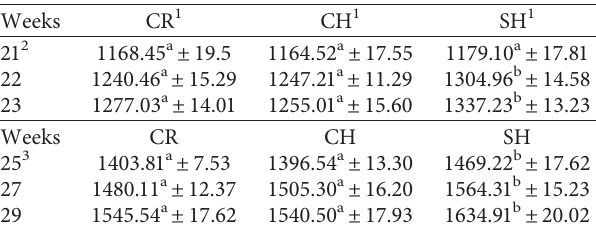
Table 4: Body weight (g) (mean ± SE) of Nicobari chickens sub- jected to different treatments.